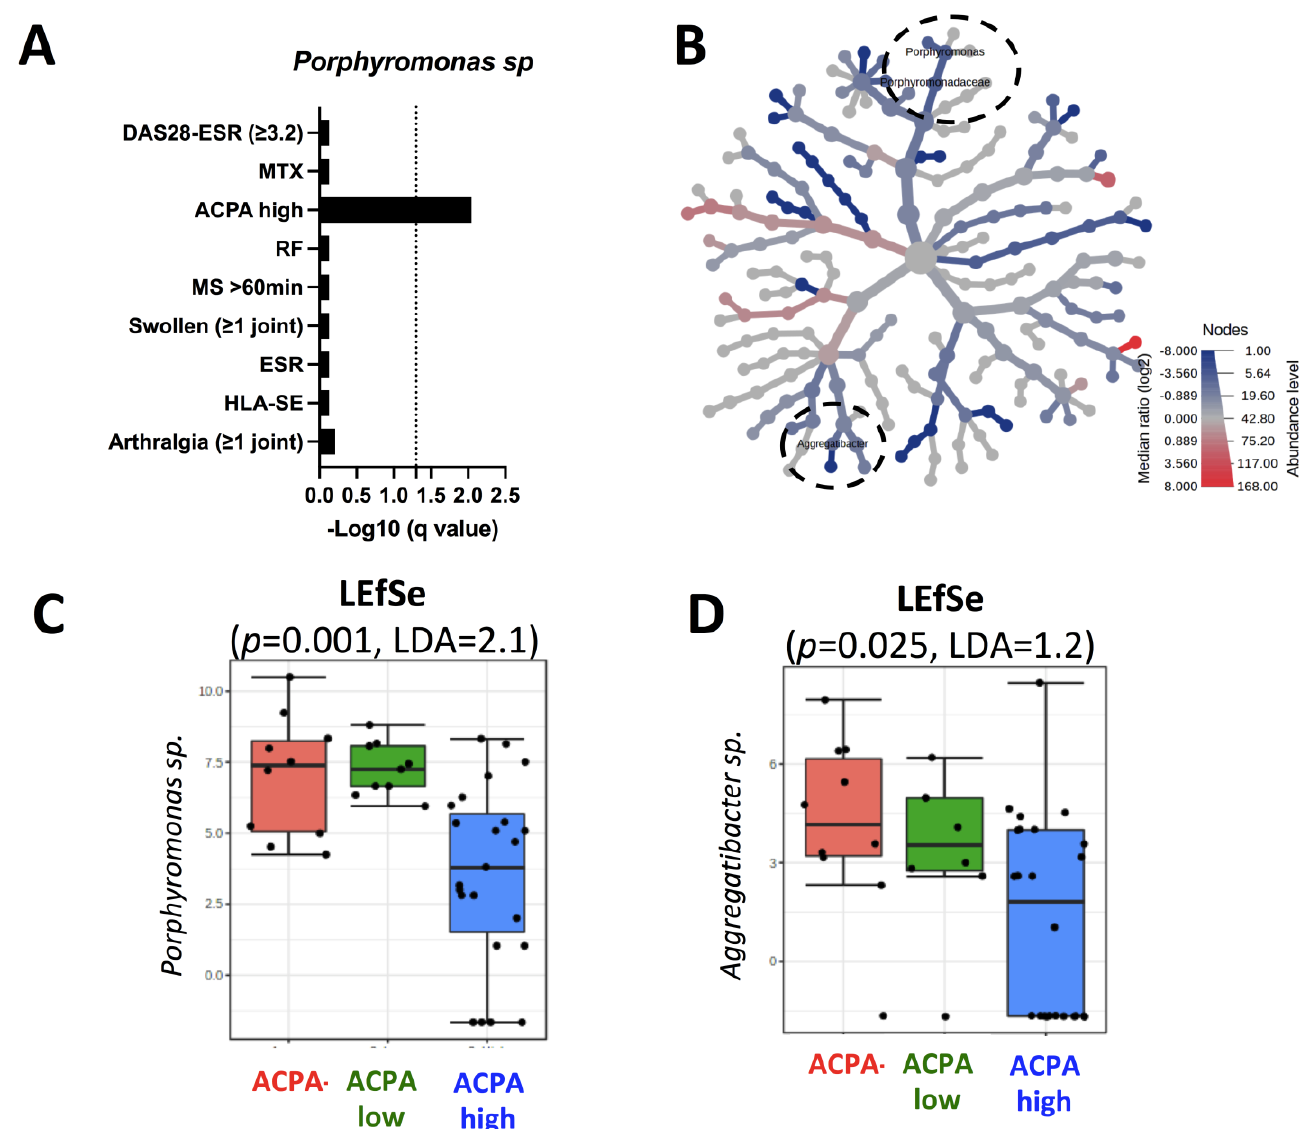
Figure 3. Elevated anti-citrullinated peptide/protein antibody (ACPA) levels are associated with oral Porphyromonas sp. and Aggregatibacter sp. level reduction in patients with rheumatoid arthritis (RA). ( A ) Association between oral Porphyromonas sp. levels and RA associated factors in 42 RA patients. ( B ) differential heat-tree matrix depicting the taxa abundance in RA patients according to the presence of ACPA at elevated levels. The red node (log 2-fold) indicates a higher abundance of the taxon, while the blue node indicates the opposite. ( C , D ) Boxplots showing specific differences in the relative abundances of discriminant Porphyromonas sp. and Aggregatibacter sp. according to the ACPA status: negative, low levels (upper limit of normal [ULN] = 1 – 2.9), and high levels (ULN > 3) ( p < 0.05).